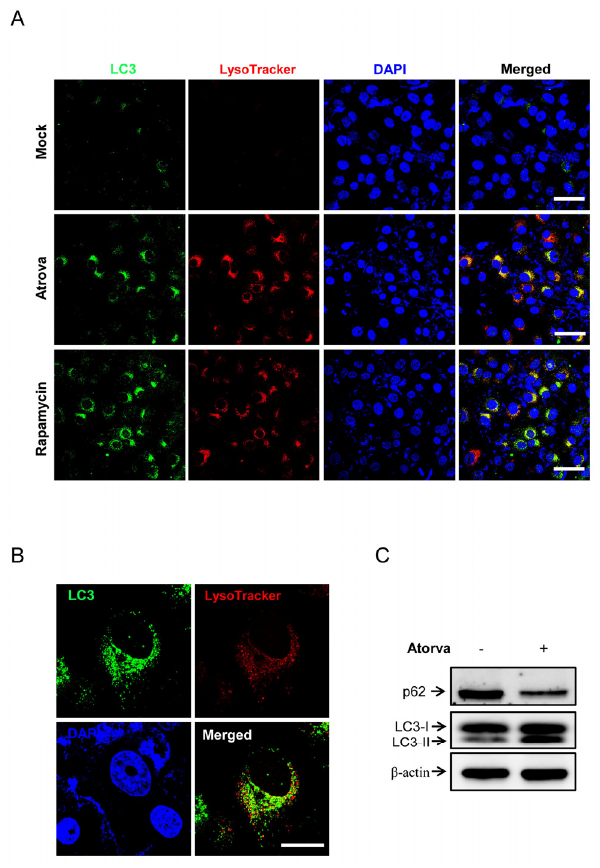
Figure 2. Autophagy induction by atorvastatin in T24 human bladder cancer cells. ( A ) Immunocytochemistry for the co-localization of LC3 puncta (green) and Lysotracker (red, demarcation for the lysosome) after atorvastatin treatments (30 μ M) for 24 h in T24 cells. Rapamycin treated T24 cells were the positive control of autophagy induction. 4',6-diamidino-2-phenylindole (DAPI) was used for nucleus staining. Scale bar = 100 μ m; ( B ) High magnification view of immunocytochemistry for the co-localization LC3 puncta (green) and Lysotracker after atorvastatin treatments (30 μ M) for 24 h in T24 cells at the single-cell level. Scale bar = 50 μ m; ( C ) Western blot analysis of autophagosome formation markers p62/SQSTM1, LC3-I and LC3-II in untreated (control) and atorvastatin (30 μ M) treated T24